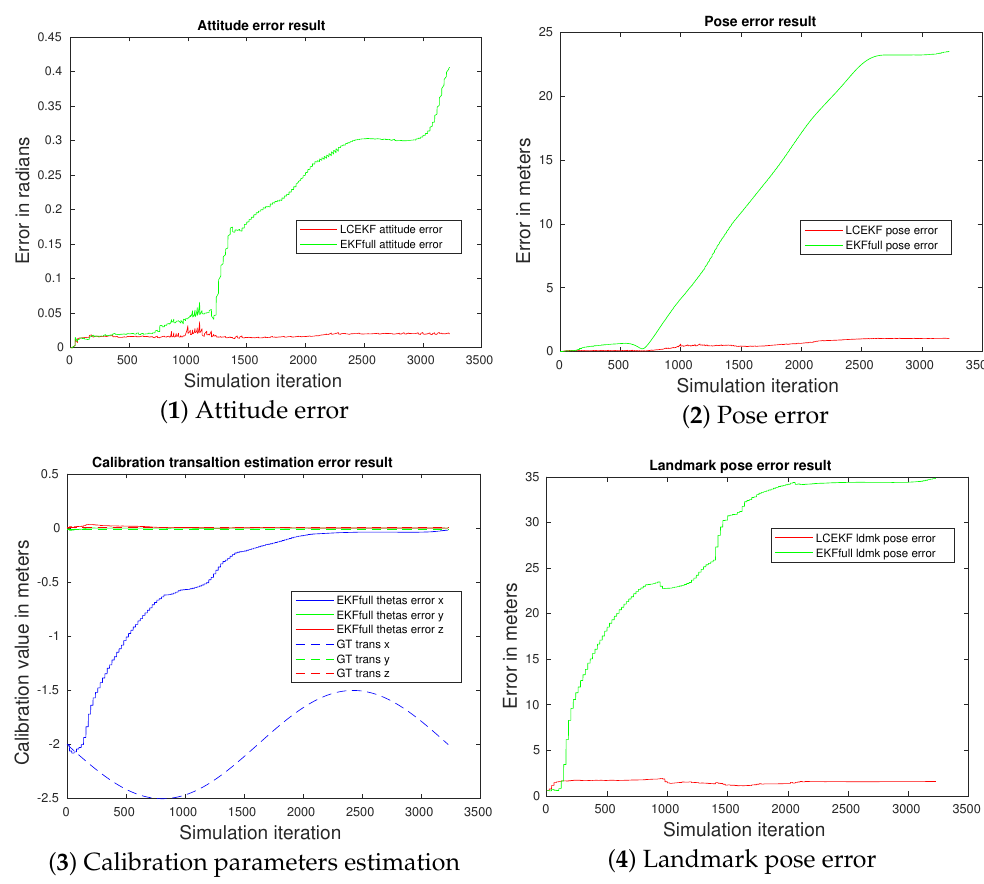
Figure 16. SLAM without the IMU and smooth sinusoidal noise. Without random walk for K parameters, the estimation was not performed properly, making the EKFfull diverge. Note that there was no impact on the LCEKF as the K parameters were not